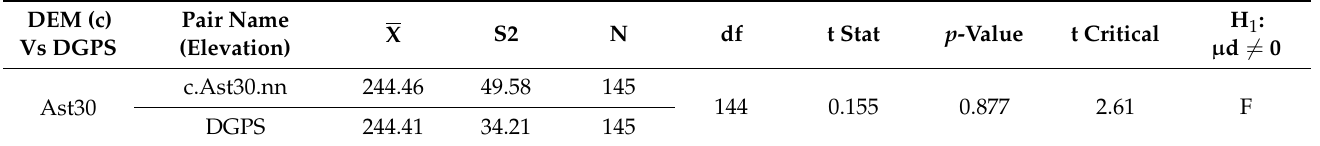
Table 9. Results of two-tail paired t -test for mean of elevation (Z) (at 99% CL & α = 0.01) carried out taking pairs of elevation values observed by “DGPS” and sampled over “corrected (c)” DEM rasters, where values were extracted by three interpolation methods: nearest neighbour (nn), bilinear (bl), and bicubic (bc) at